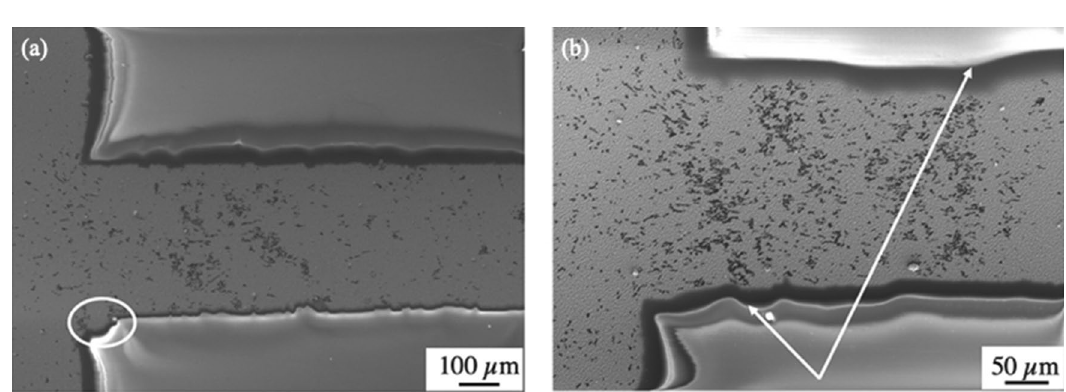
Figure 8. Imperfections in the film ( a ) shape of the sample after uninterrupted EM for 650 h ( b ) shape of the sample checked at regular